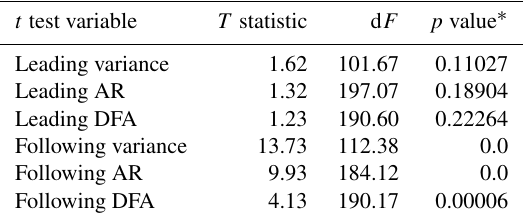
Table 4. Results of Student’s t test on the differences between the ratios (in Table 3) of the cases with and without second